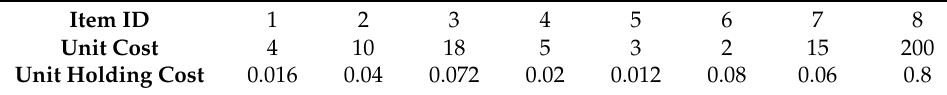
Table 2. Capacity consumed per time period by a unit in trans-shipment nodes.